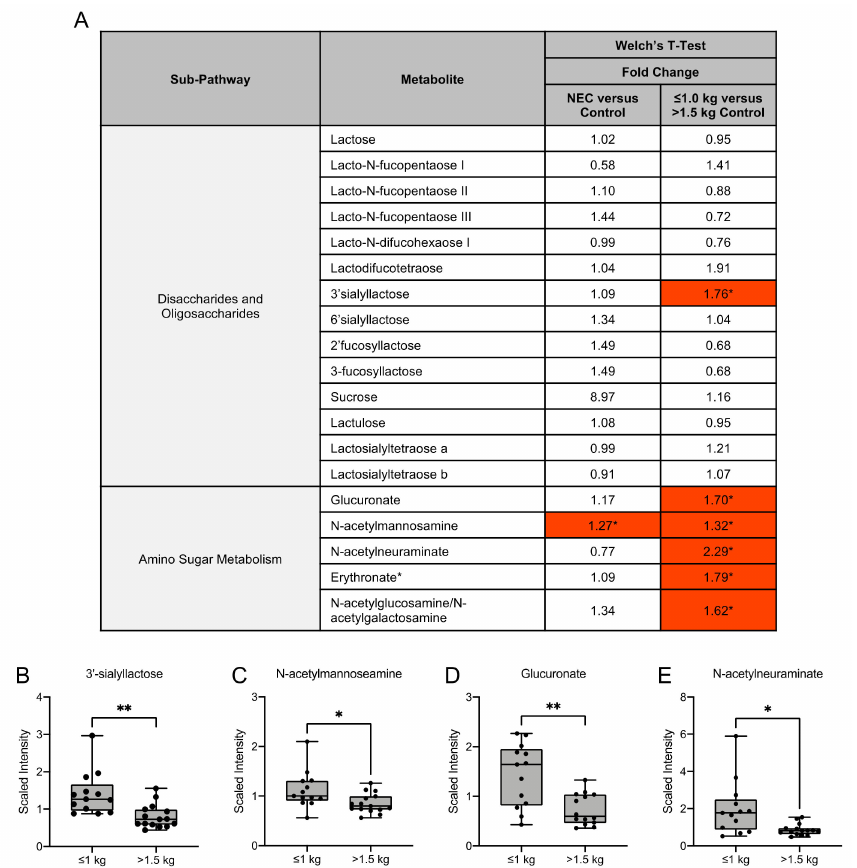
Figure 4. Human milk oligosaccharide and amino sugar composition of human milk differs among birth weight control milk samples. ( A ) Fold change concentration of human milk oligosaccharides and amino sugar metabolites in maternal milk. Red cells indicate mean values that are significantly higher and blue cells indicate mean values that are significantly lower for the designated comparison. ( B – E ) Boxplots of concentration levels of 3 (cid:48) sialyllactose, N-acetylmannosamine, glucuronate and N-acetylneuraminate between the birth weight control groups. * p ≤ 0.05, ** p < 0.01 by Welch’s T